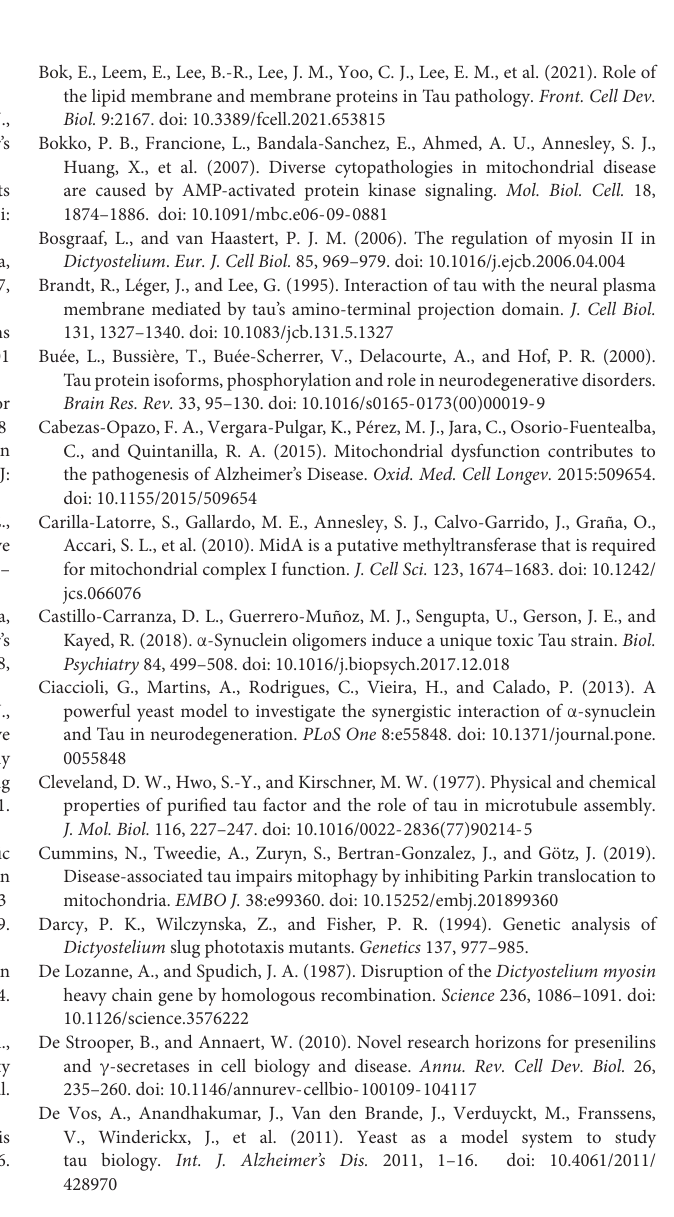
Supplementary Table 1 | Tau up-regulated